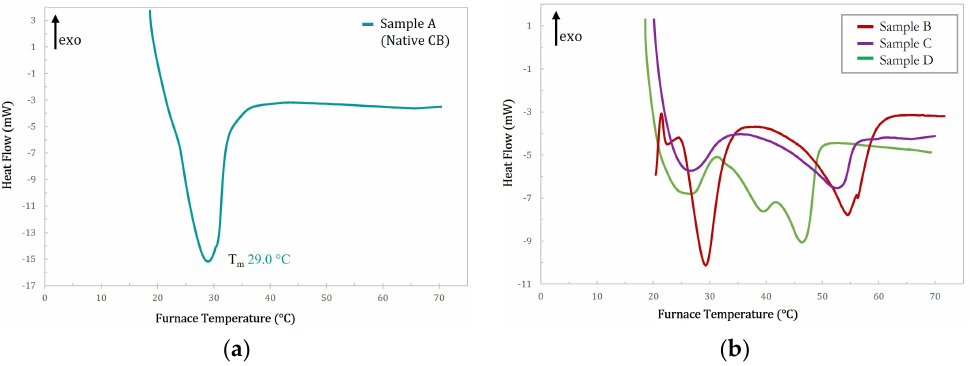
Figure 2. Melting profile (endo-down) of ( a ) native CB (sample A, blue curve) and ( b ) modified samples B (red curve), C (purple curve), and D (green curve).